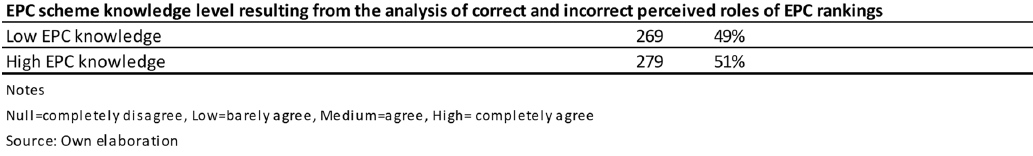
Total Answers (N)